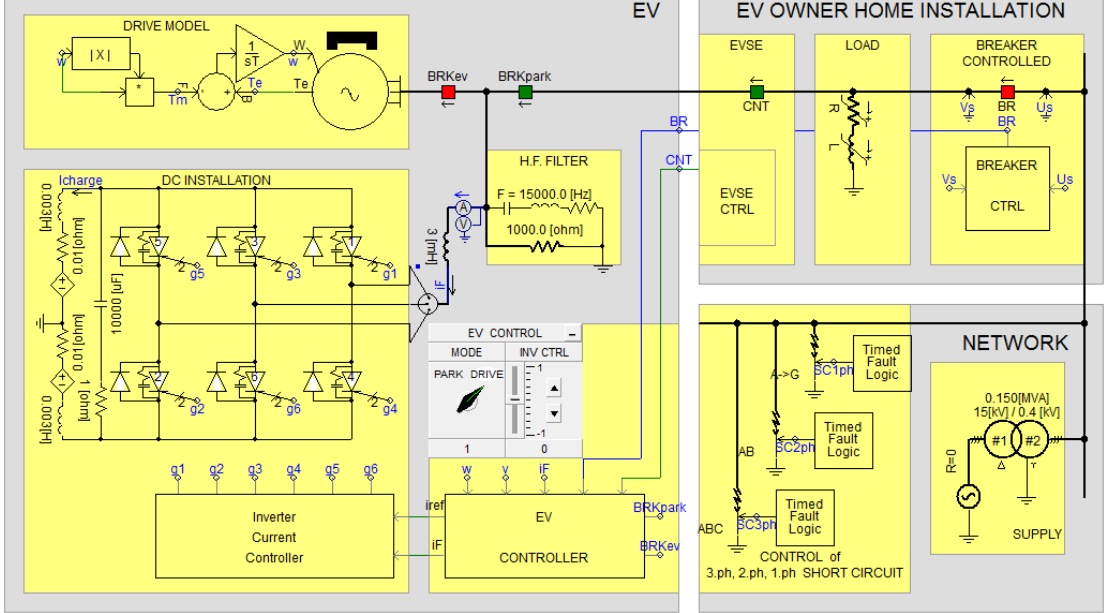
Figure 2. Schematic diagram of an electric vehicle (EV) and home installation simulator mode.